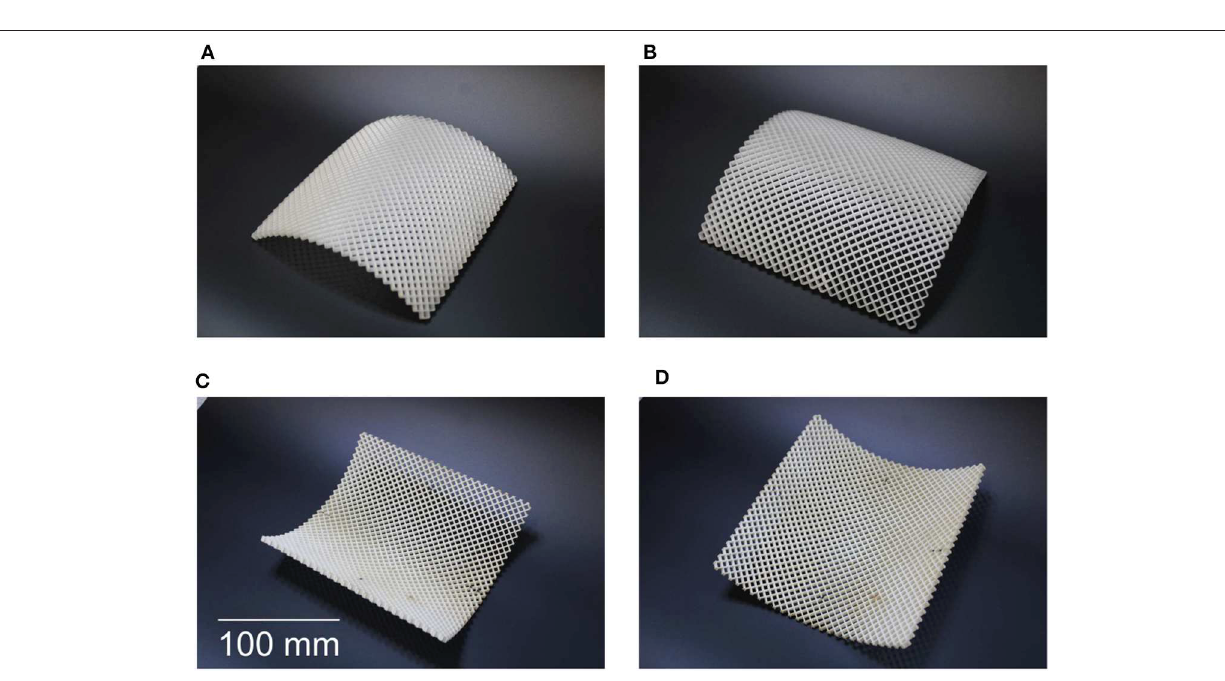
170 mm, θ 5 π/ 6, h 5 mm, d 5 mm, and w 1 mm. Second stable geometries for the two structures are shown in (B,D) = = = = =